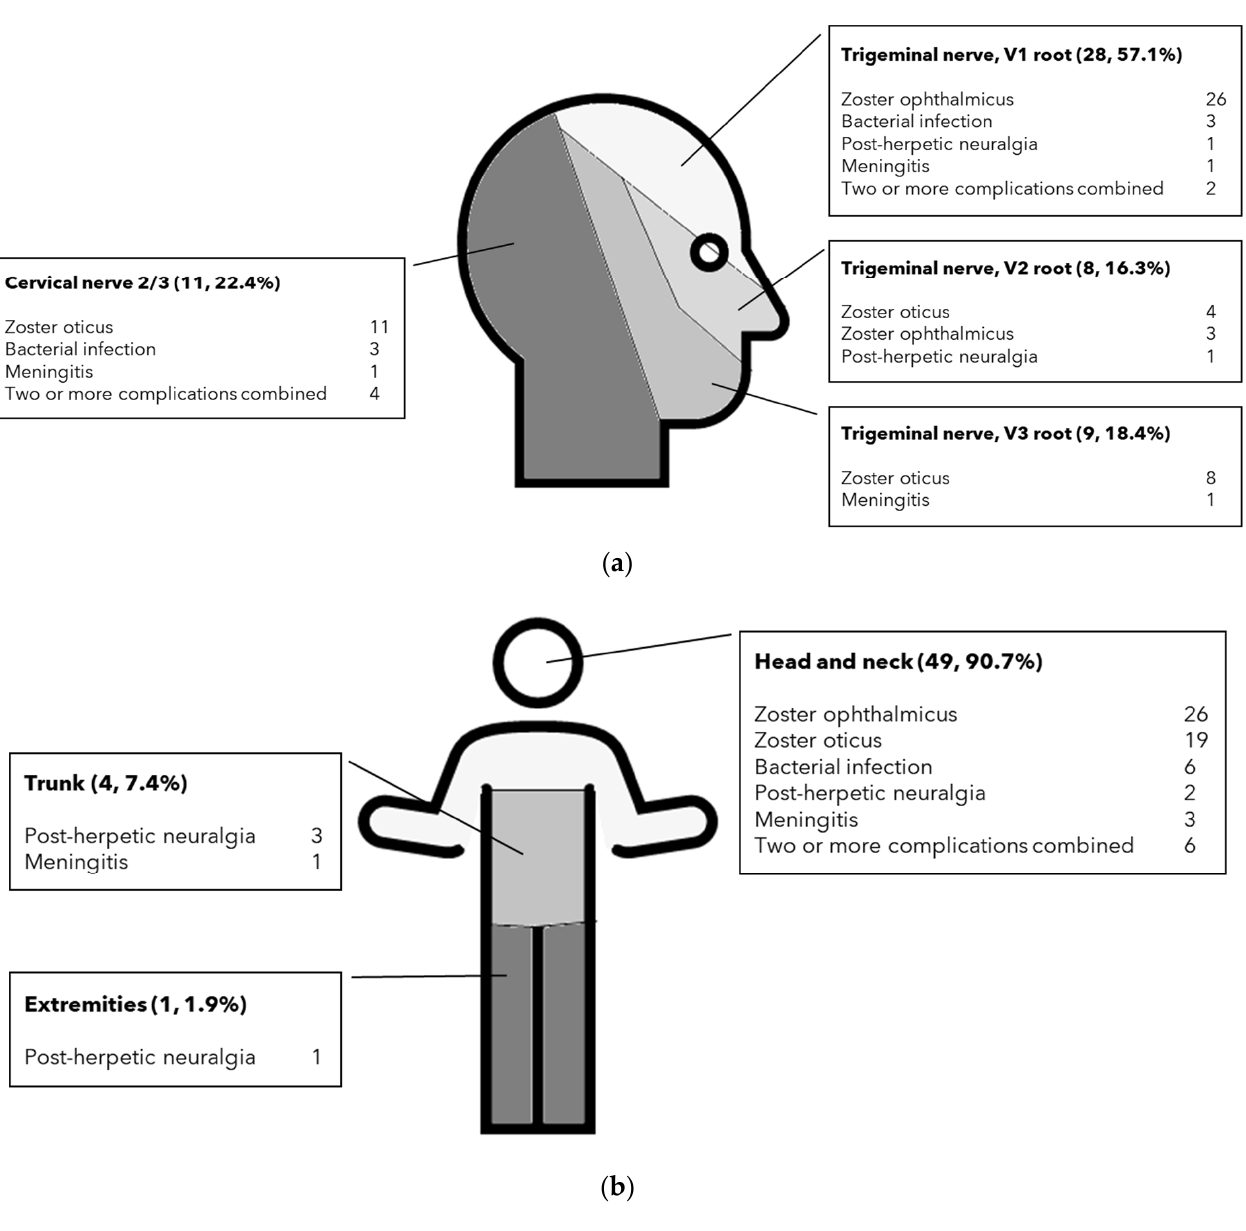
Figure 4. Distribution of complications according to dermatome: ( a ) head and neck involvement ( b ) whole-body distribution. Table 2. Types of complications ( n = 54).